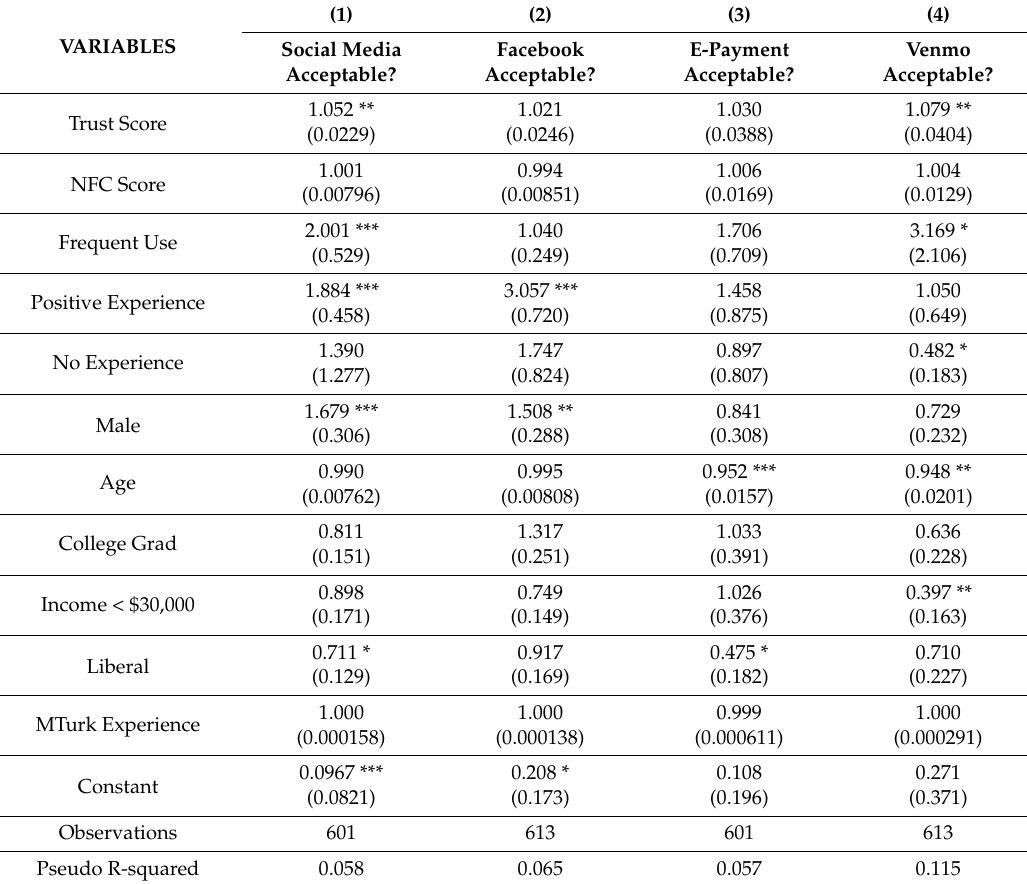
Table 8. Logistic regressions for scenarios involving online interactions (coefficients presented as odds